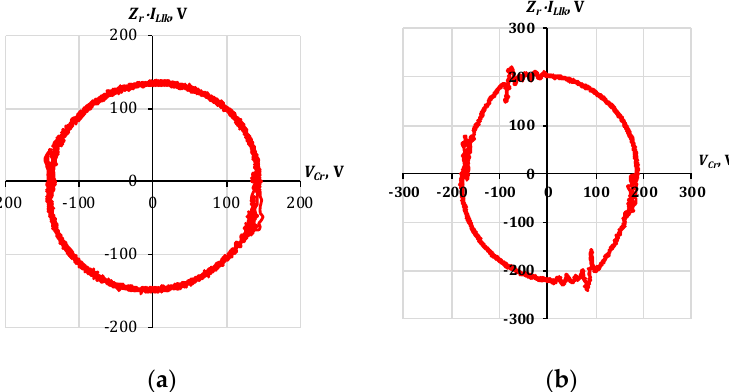
Figure 9. Experimental state-plane trajectory for the proposed converter at P IN = 300 W corresponding to ( a ) the DCX mode and ( b ) the boost mode.